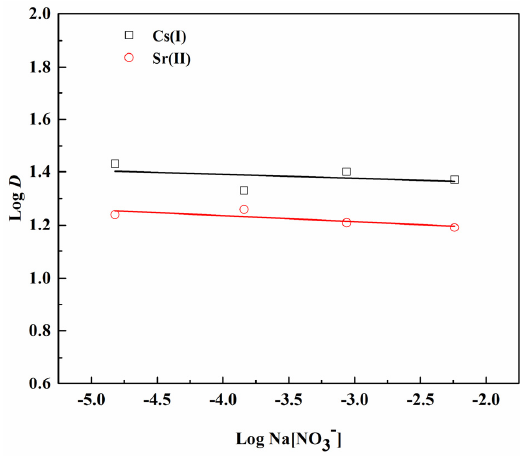
Figure 5. Relationship between log D and log Na[NO 3 − ]. Conditions: T = 298 K, pH = 6, [SC4A] (o) = 1 × 10 − 3 M, [Cs + ] (a) = [Sr 2+ ] (a) = 1 × 10 − 4 M, contact time = 60 min, shaking speed: 150 rpm.